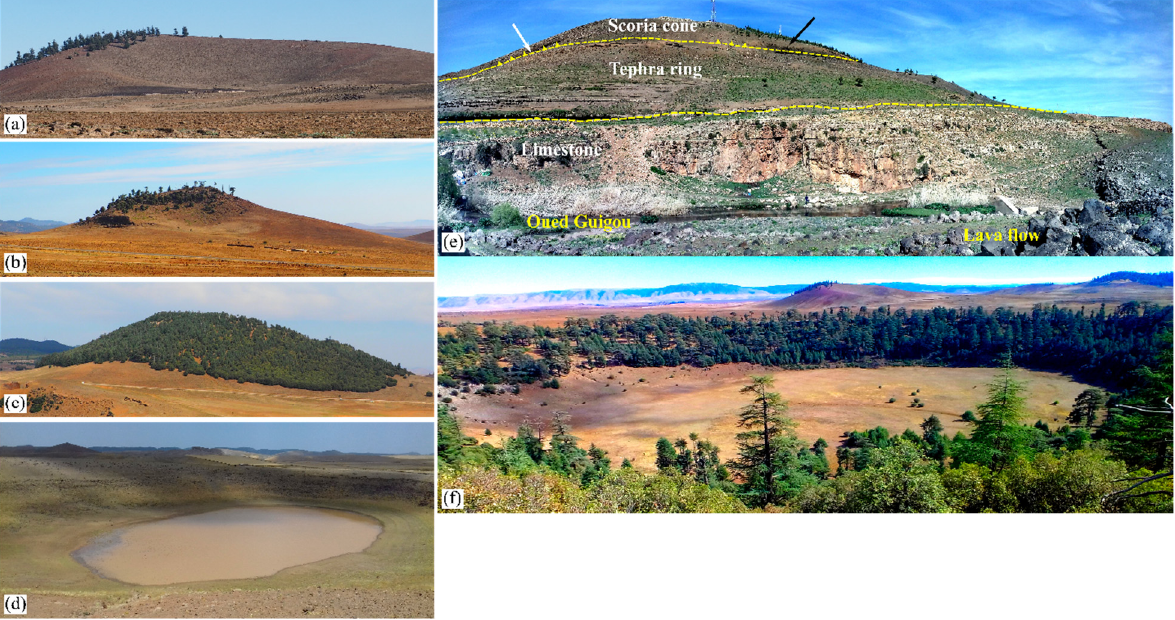
Figure 10. Scoria cones: ( a ) Boutjatiout cone ; ( b ) Ta’issaouit (Ta 2) cone; ( c ) Hebri cone. Maars: ( d ) Lachmine Ghaline maar; ( e ) Timahdite (maar-cone), black arrow shows the pozzolan quarry, white arrow shows the unconformity between the maar and the cone [30]; ( f ) Lachmine N’kettane maar.